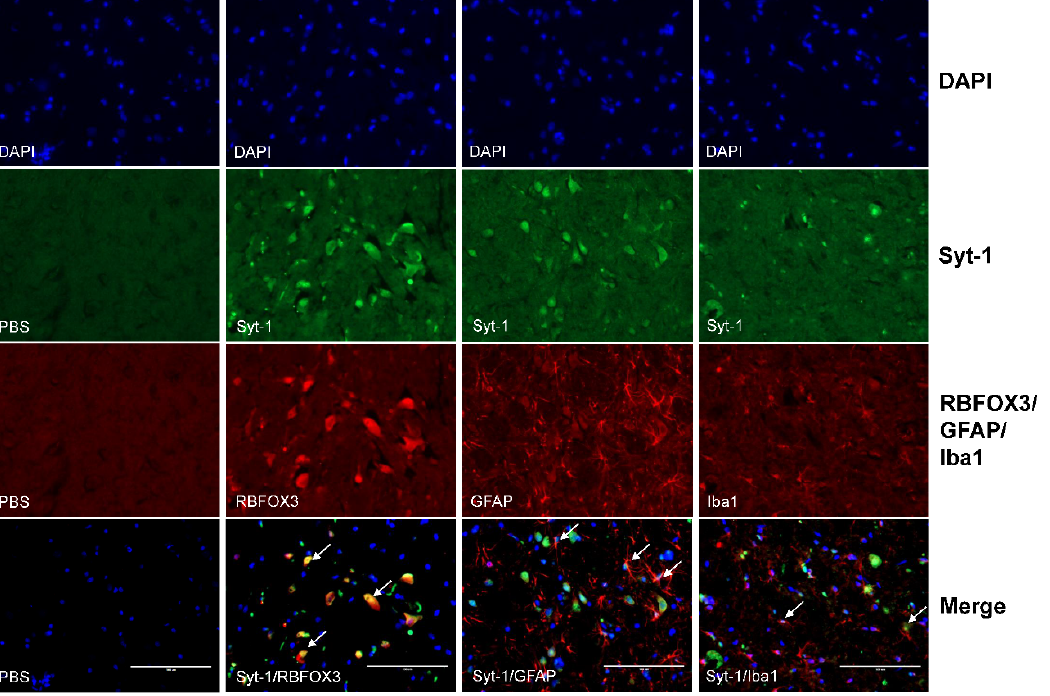
Figure 8. Colocalization of Syt-1 with the marker of neurons, astrocytes, or microglial cells in the SCDH. Co-labeling with RBFOX3 (a marker for neurons) and GFAP (a marker for astrocytes) antibodies showed that Syt-1-IR (in green) mainly exists in neurons and astrocytes (in red). Weak Syt-1-IR signal was observed in few microglial cells stained with Iba1 (a marker for microglial cells) antibodies. White arrows show the colocalization of Syt-1 with neurons, astrocytes, or microglial cells. Scale bars, 100 µ m.